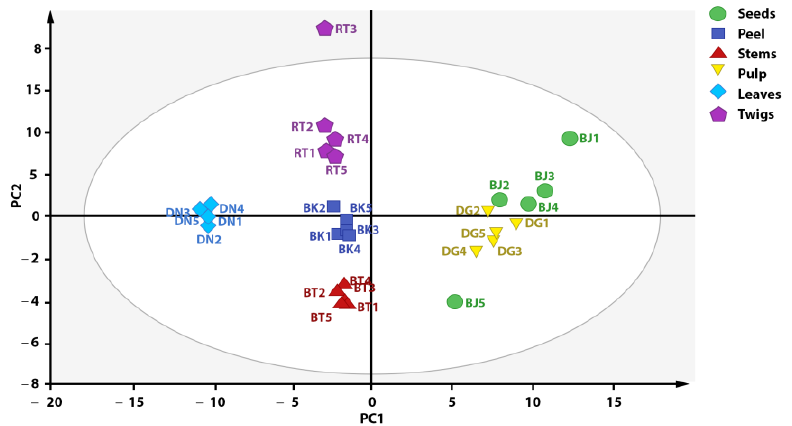
Figure 3. Score plot of PCA analysis before outlier reduction.